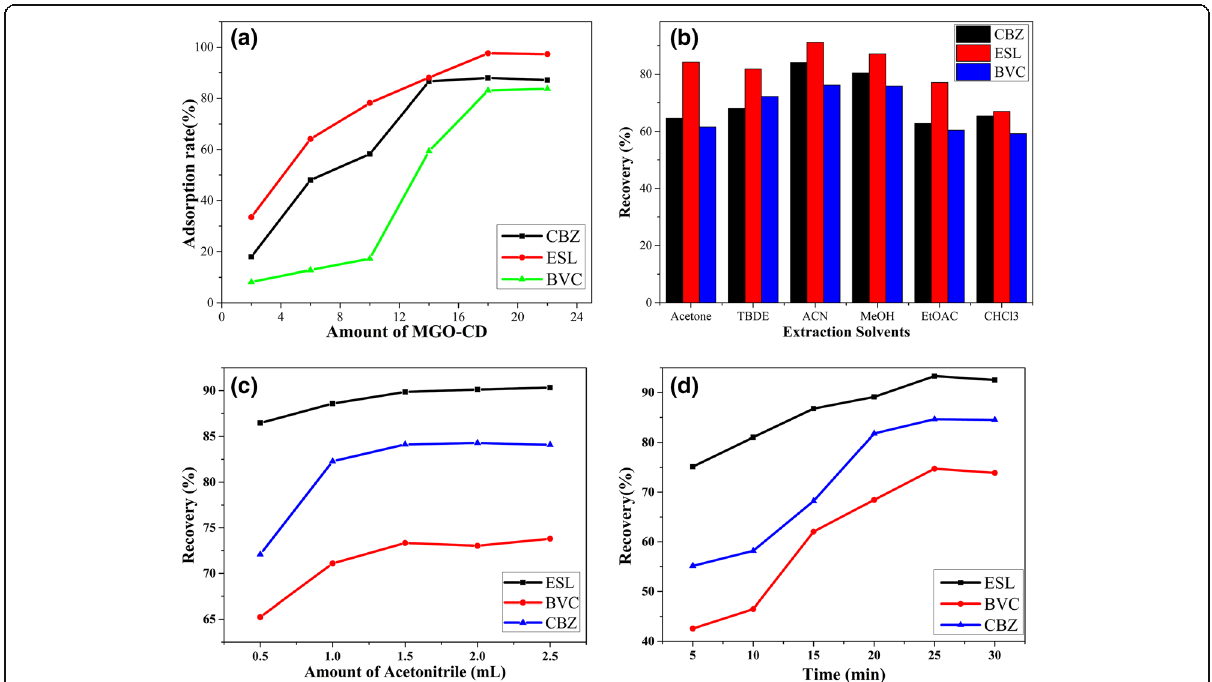
Fig. 8 a The effect of MGO-CD amount. b The effect of deferent solvents. c The effect of solvent amount. d The effect of time on extraction